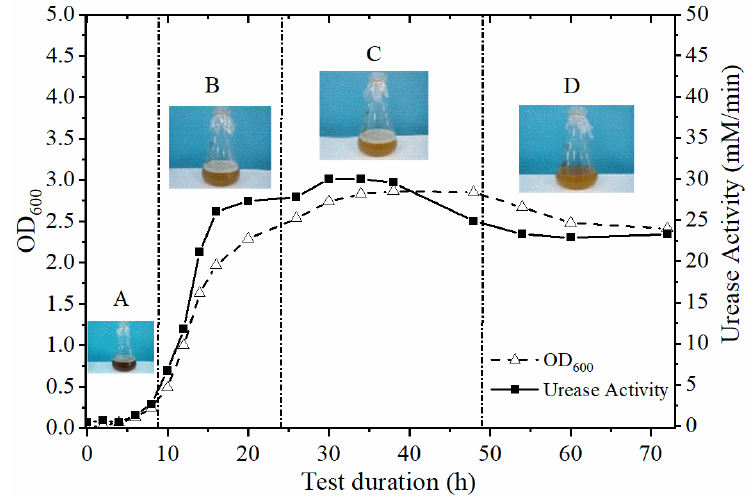
Figure 1. The microorganism growth characteristic curve: ( A ) adjustment period; ( B ) logarithmic period; ( C ) stable period; ( D ) decay period.